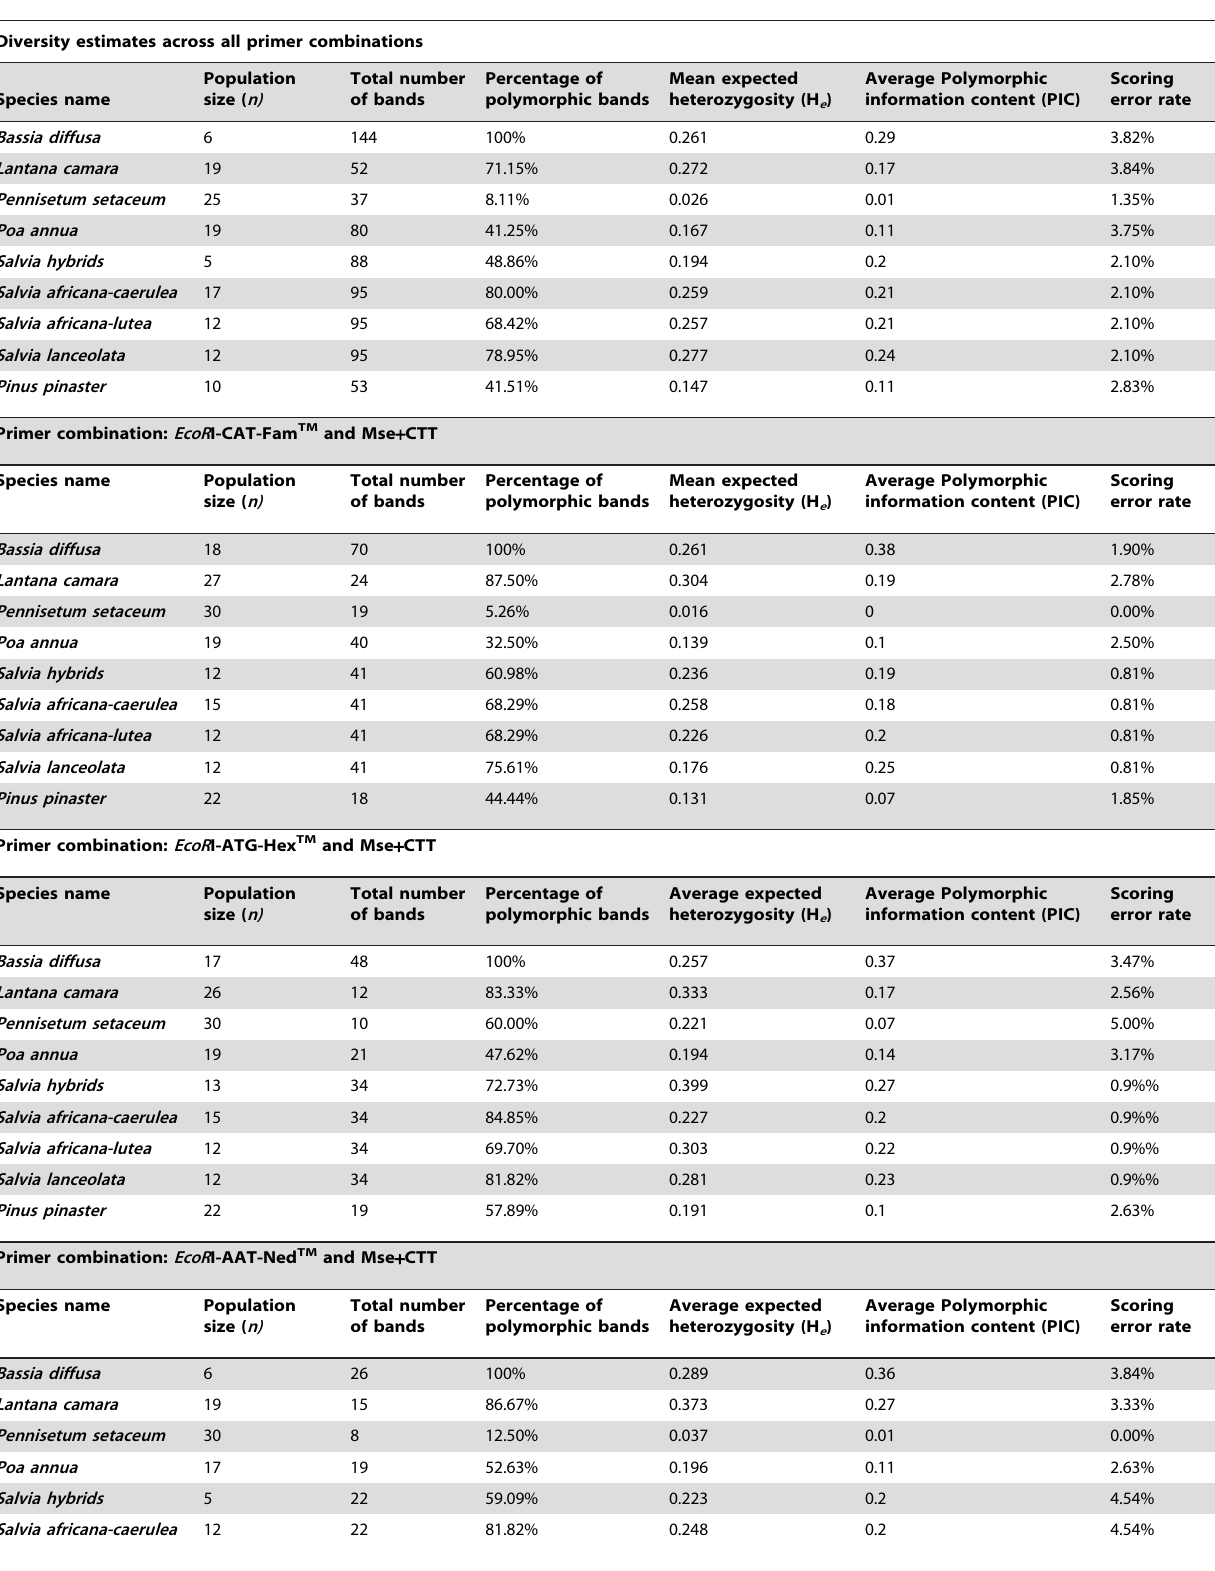
Table 2. Summary data for Bassia diffusa, Lantana camara, Pennisetum setaceum, Poa annua, Salvia sp. hybrids, Salvia lanceolata , Salvia africana-lutea, and Salvia africana-caerulea and Pinus pinaster .